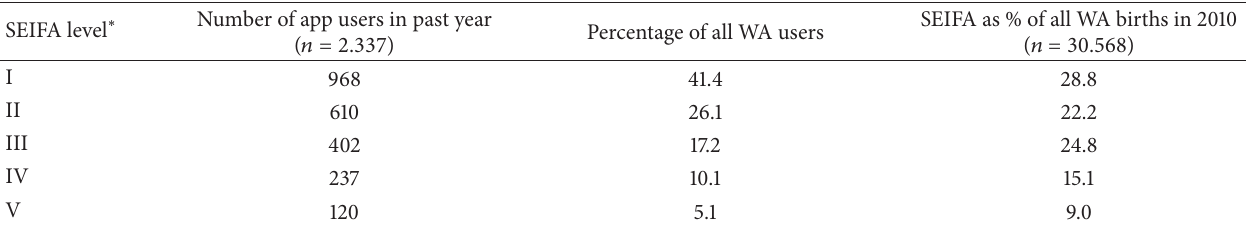
Table 4: Number and percentage of app users and percentage of Western Australian births by SEIFA. SEIFA level